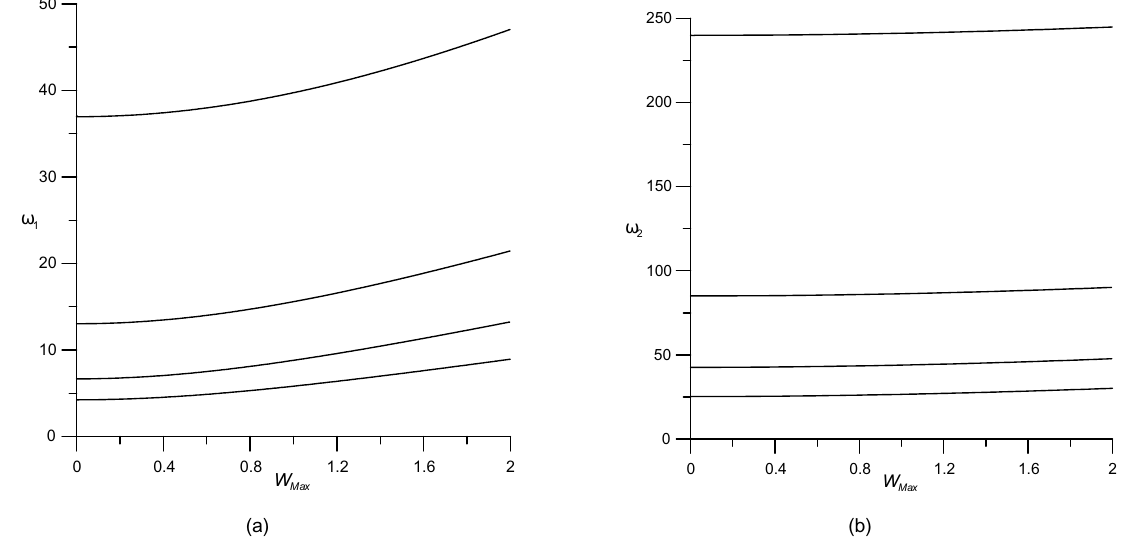
Fig.5. Thefirst(a)and second (b)natural frequencies ofthe plate asfunctions ofthe maximumnondimensional deflection W Max forfree-clamped plates of inner radii b = 0 . 1 , 0 . 3 , 0 . 5 , and 0 . 7 . mensional